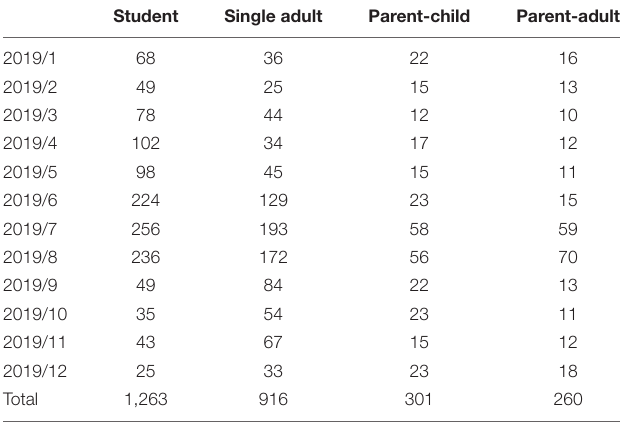
TABLE 4 | The distribution of secondary consumption visitors in the dining